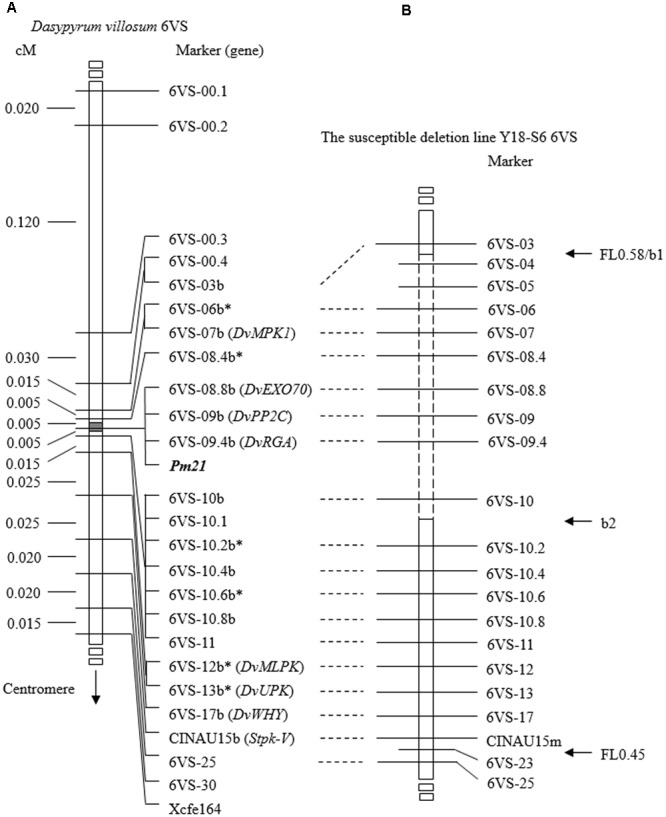
Genetic and physical mapping of Pm21. (A) Genetic map of Pm21 and 6VS markers obtained by using the F2 population derived from the cross between the resistant D. villosum DvRes-1 and the susceptible DvSus-1. The gray block on the chromosome 6VS denotes the genetic interval carrying Pm21. All markers used here were derived from genes based on comparative genomics among wheat crops and Brachypodium and designated according to the gene order in Brachypodium. The DNA markers marked by b and the corresponding ones were developed from the same gene. The asterisks indicate single nucleotide polymorphism (SNP) markers. The genes in brackets were reported previously (Cao et al., 2011; He et al., 2016) or first named in this study. (B) Physical map of Pm21 obtained by using the susceptible deletion line Y18-S6. CINAU15m was a co-dominant marker newly developed from Stpk-V gene in this study. The 6VS chromosome breakpoints b1 and b2 in Y18-S6 as well as the bin FL0.45–0.58 are pointed by horizontal arrows. The dashed box represents the chromosomal deletion region in Y18-S6. The vertical arrow shows the direction of the centromere of 6V.